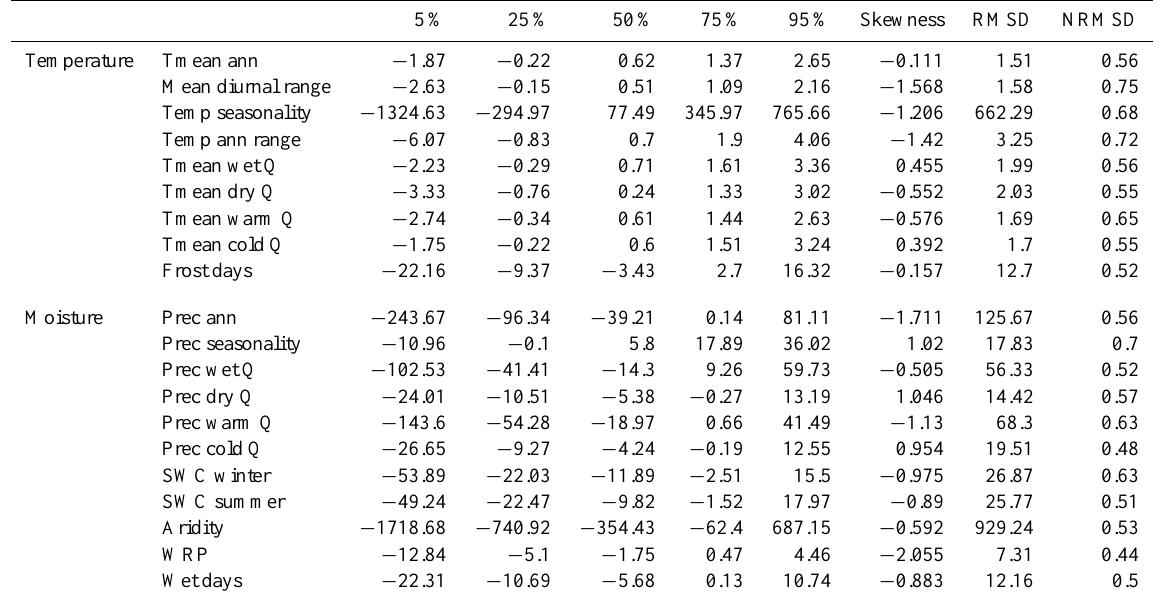
Table 2. Summary of the dispersion of the anomalies δ v (s) (5, 25, 50, 75 and 95% quantiles), skewness, RMSD and NRMSD of each variable. The medians are statistically different from